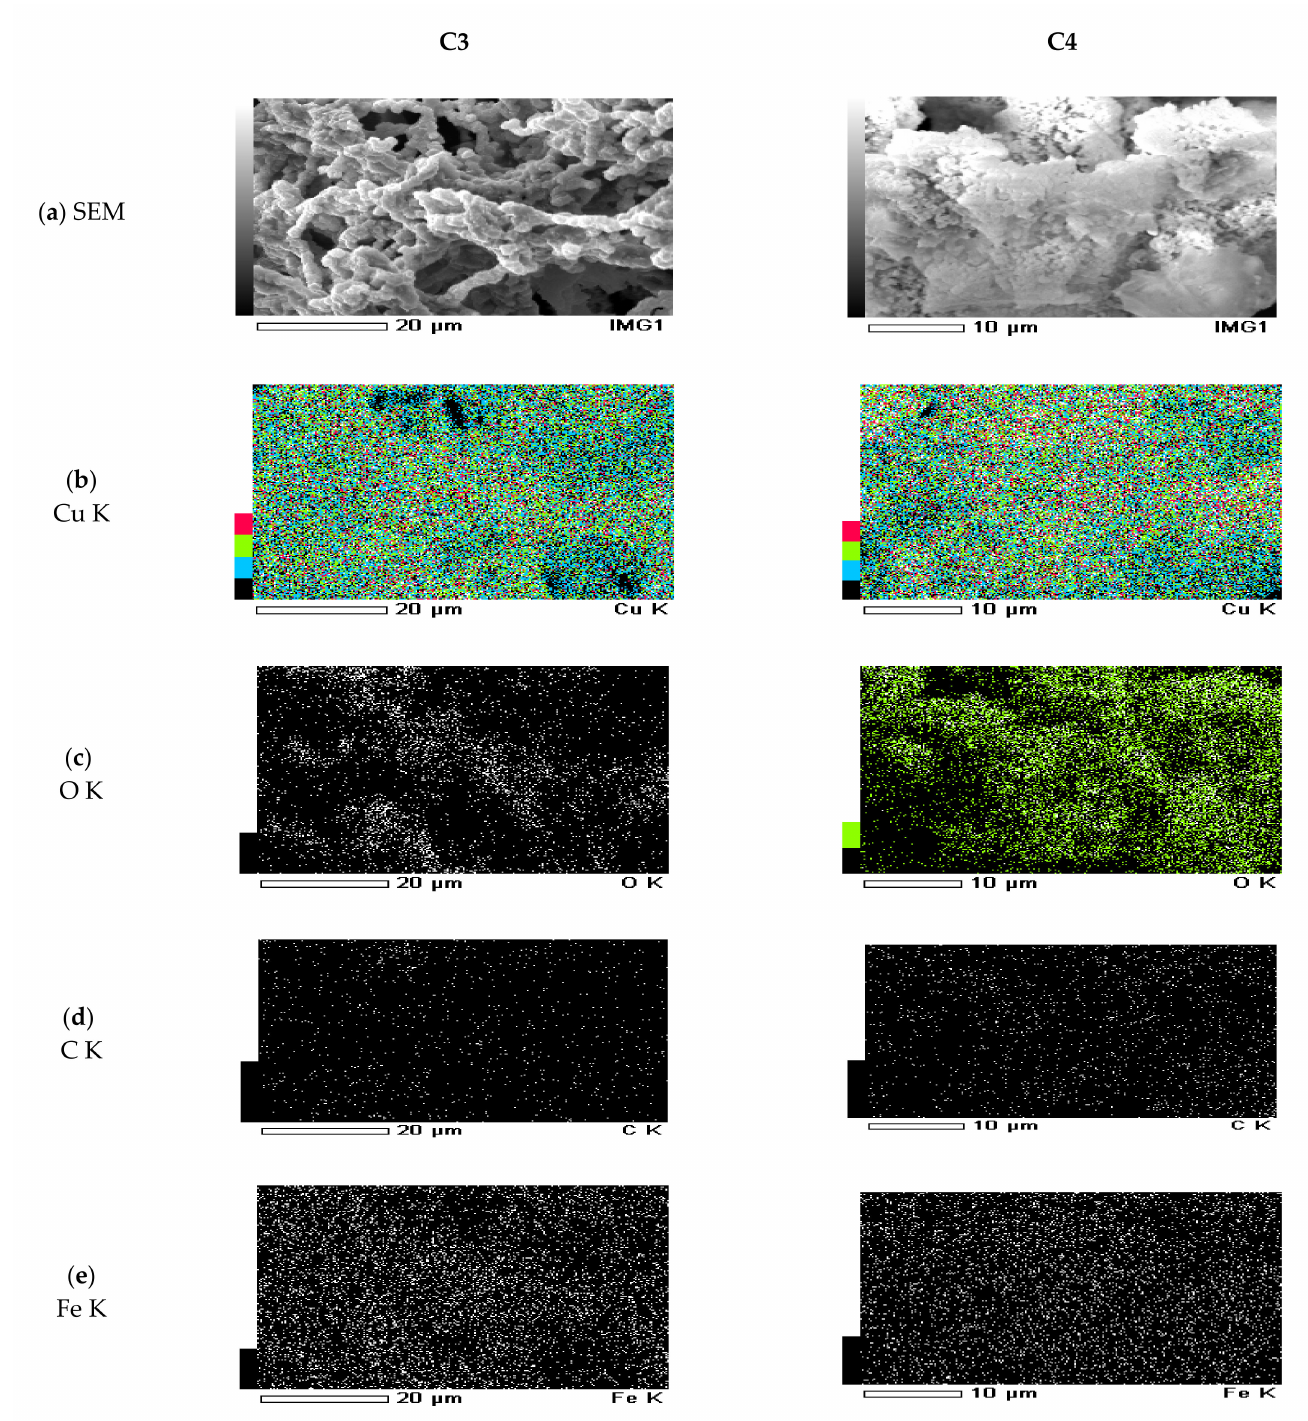
Figure 6. Energy dispersive spectrometry (EDS) elemental mapping analyses of the samples C3 and C4: ( a ) SEM, ( b ) Copper distribution, ( c ) Oxygen distribution, ( d ) Carbon distribution, and ( e ) Iron Fe